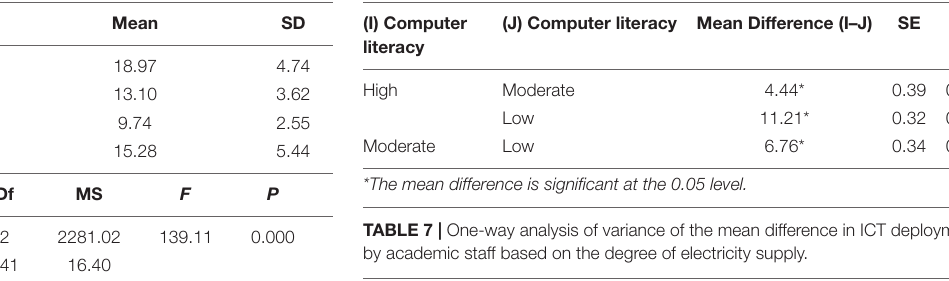
TABLE 3 | One-way analysis of variance of the mean difference in ICT deployment by academic staff based on the cost of data levels.